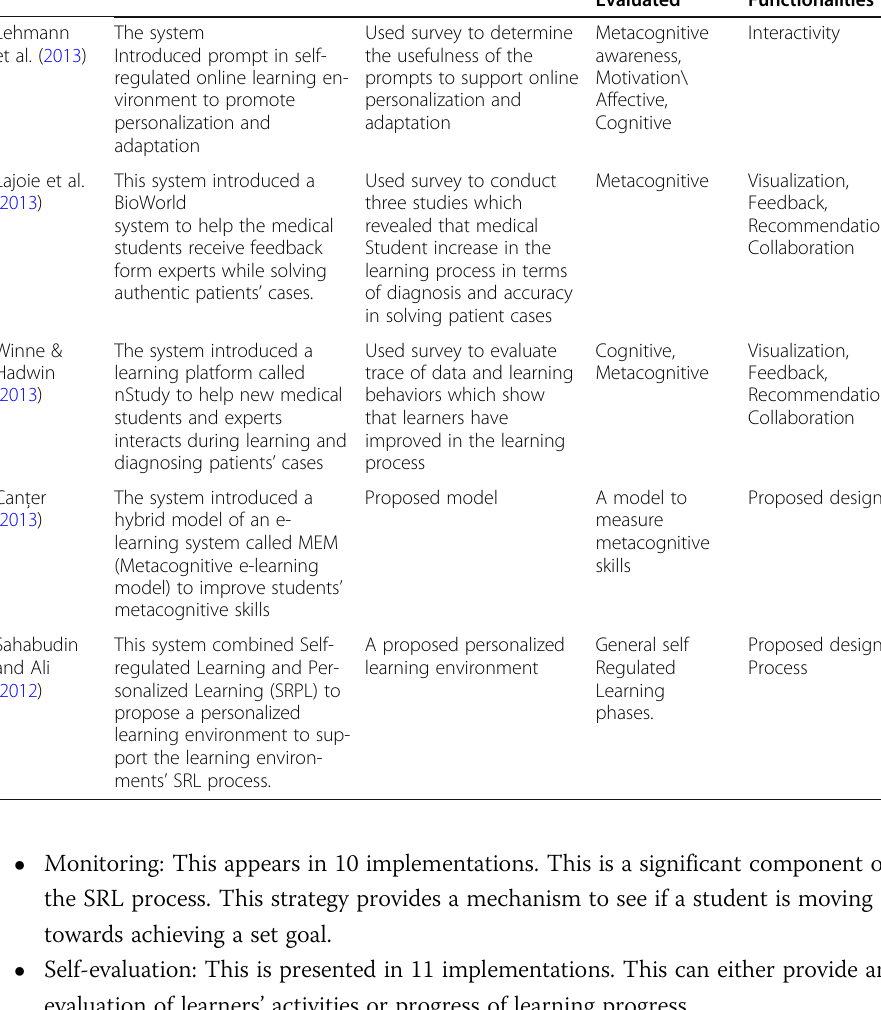
Reference Description of Application Evaluation